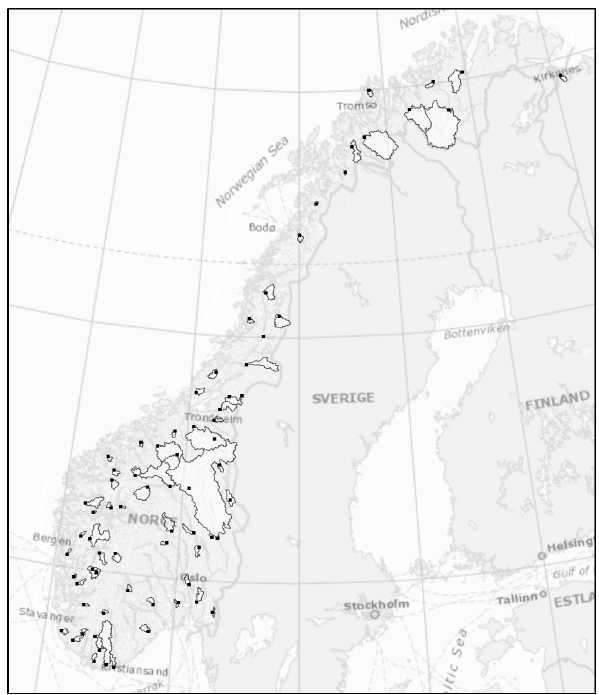
Figure 5. Location of the 73 catchments used to evaluate the new storage